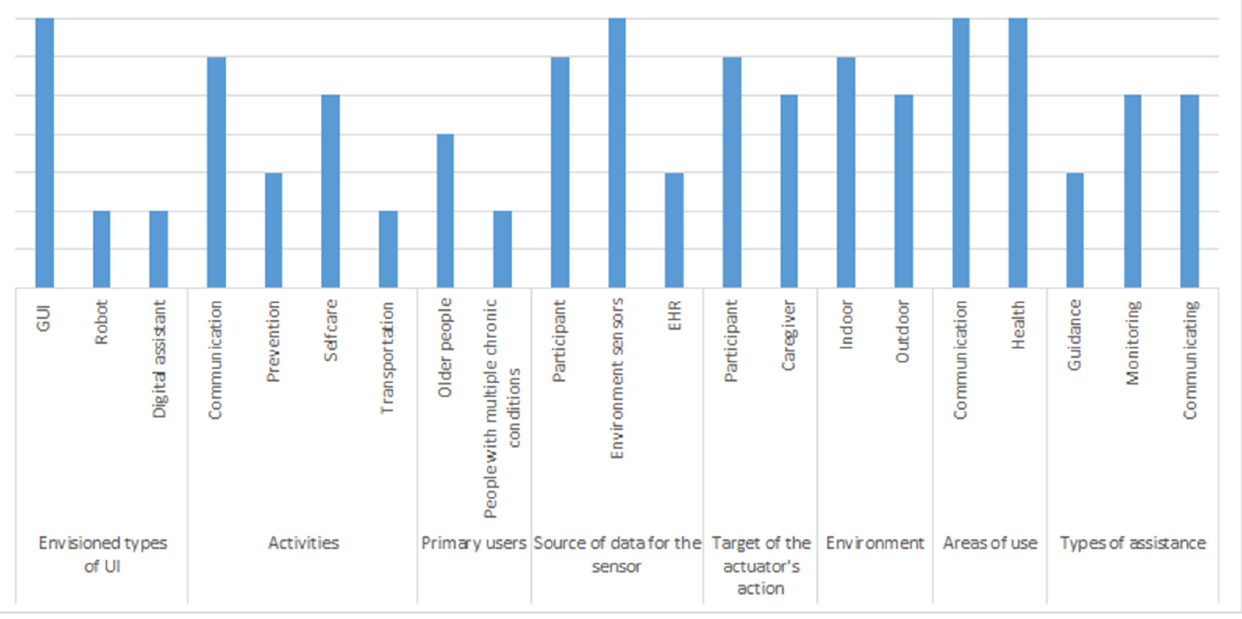
Figure 5. PHS taxonomy-based classification commonalities summary.